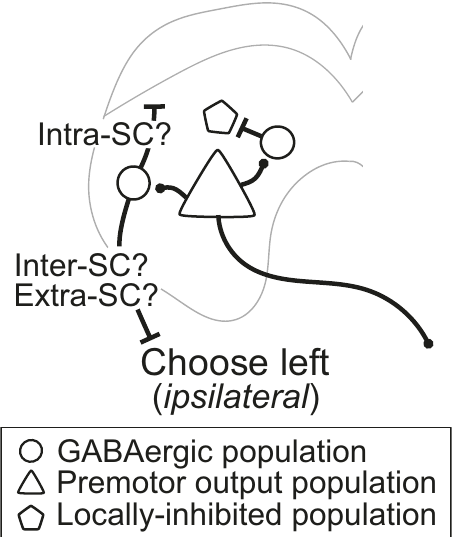
Fig. 7 Functional long-range inhibition from GABAergic SC neurons promotes contralateral choices. Long-range projections by which GABAergic SC neurons may promote contralateral